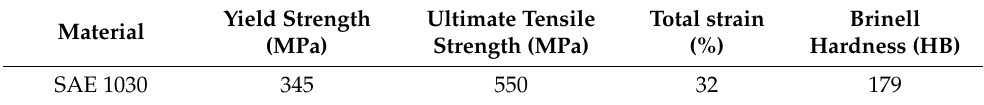
Table 3. Mechanical properties of SAE 1030 [25].